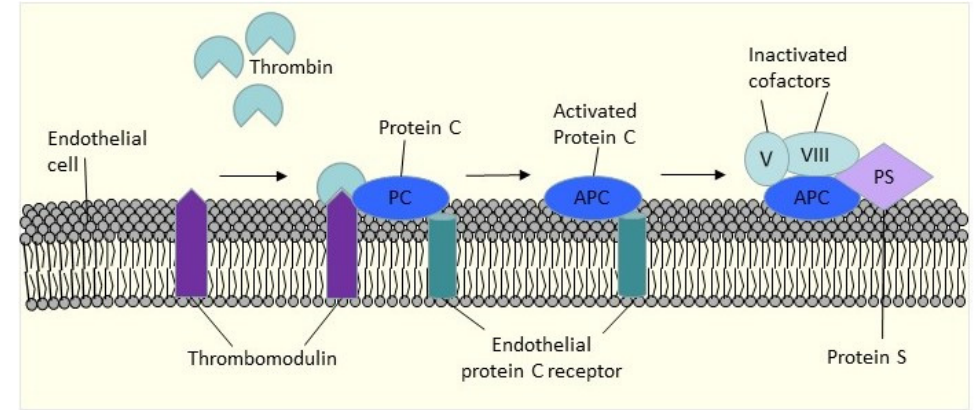
Figure 2. Protein C pathway.